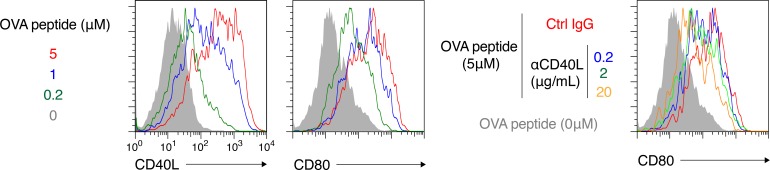
Representative FCM profile data from the analyses shown in Figure 5b–d.